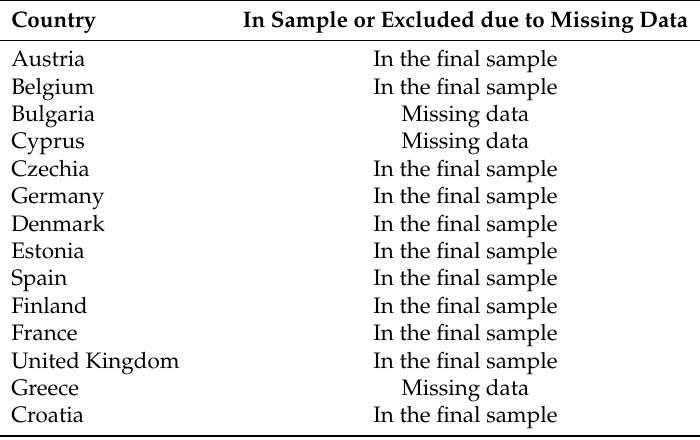
Table A2. Overview of countries in our sample for the MLR. Missing countries were excluded due to missing data on the 10 independent variables. Our sample contains 18 out of 28